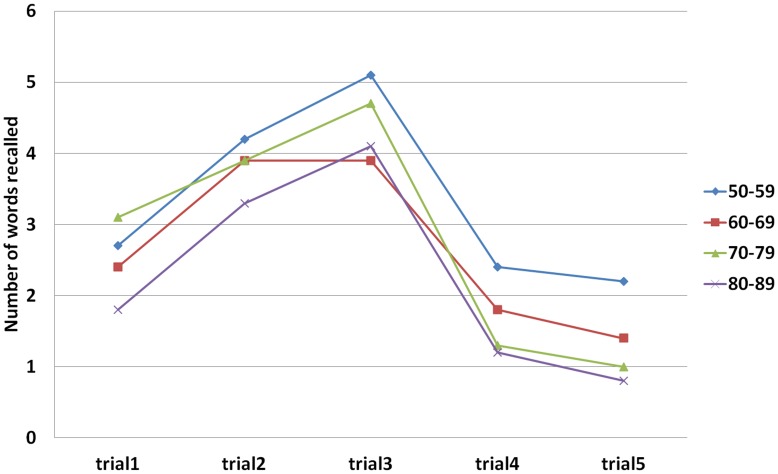
AVL scores of different age groups in each trial in patients with aMCI.